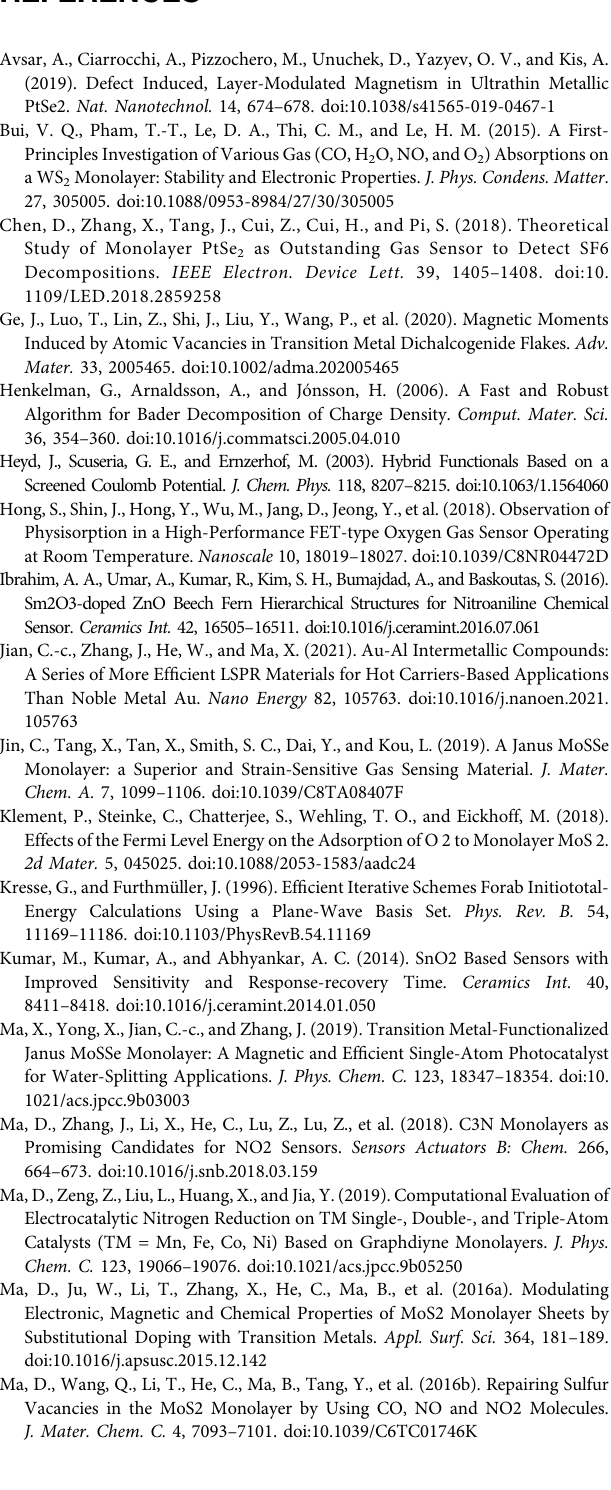
Algorithm for Bader Decomposition of Charge Density. Comput. Mater. Sci. 36, 354 – 360.